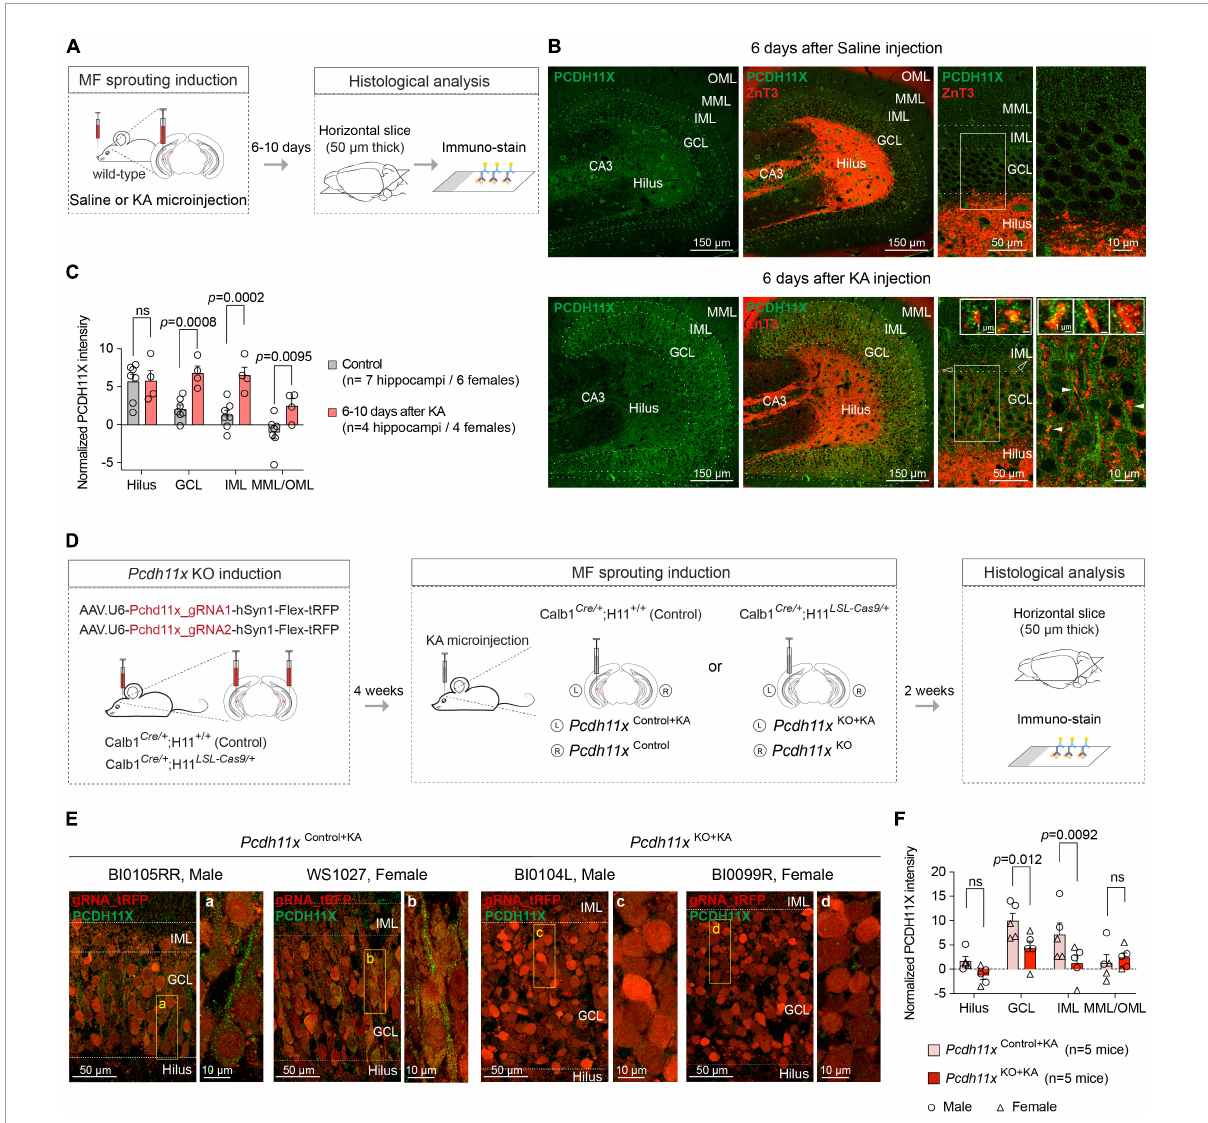
FIGURE3 PCDH11X protein expression in the dentate gyrus. (A) Schematic representation of the experimental design. (B) Confocal images show PCDH11X and ZnT3 immunostaining in the dentate gyrus 6 days after saline (upper row) and KA injection (lower row). From left to right, PCDH11X immunostaining, PCDH11X and ZnT3 immunostaining, higher magnification images of the PCDH11X and ZnT3 immunostaining, and finally higher magnification images of the regions highlighted with white frames in the previous panels are shown. In the lower right panels, inserts show PCDH11X localization in ZnT3 + MF boutons in IML (empty arrowheads) and in GCL (white arrowheads). (C) Quantification of the PCDH11X signal in controls and 6–10 days after KA (two-way ANOVA, F Layer (3,27) = 17, p < 0.0001; F Treatment (1,9) = 14, p = 0.0051; F LayerxTreatment (3,27) = 5.1, p = 0.0066; post hoc analyses: control vs KA, hilus: ns, p = 0.94; GCL: p = 0.0008; IML: p = 0.0002; MML/OML: p = 0.0095). (D) Schematic representation of the experimental design in Cas9-expressing and -non-expressing mice. (E) Confocal images show PCDH11X immunostaining in the dentate gyrus of Pcdh11x Control + KA and Pcdh11x KO + KA mice 14 days after KA. Areas highlighted with boxes are shown in higher magnification in panels (a–d) . (F) Quantification of tRFP-normalized PCDH11X levels in dentate gyrus of Pcdh11x Control + KA and Pcdh11x KO + KA mice [two-way ANOVA, F Layer (3,24) = 19, p < 0.0001; F KO (1,8) = 3.7, p = 0.091; F LayerxKO (3,24) = 5.5, p = 0.0049; post hoc analyses: Pcdh11x Control + KA vs Pcdh11x KO + KA , hilus: ns, p = 0.17; GCL: p = 0.012; IML: p = 0.0092; MML/OML: p = 0.62] (for tRFP-non-normalized values see Supplementary Figure 2